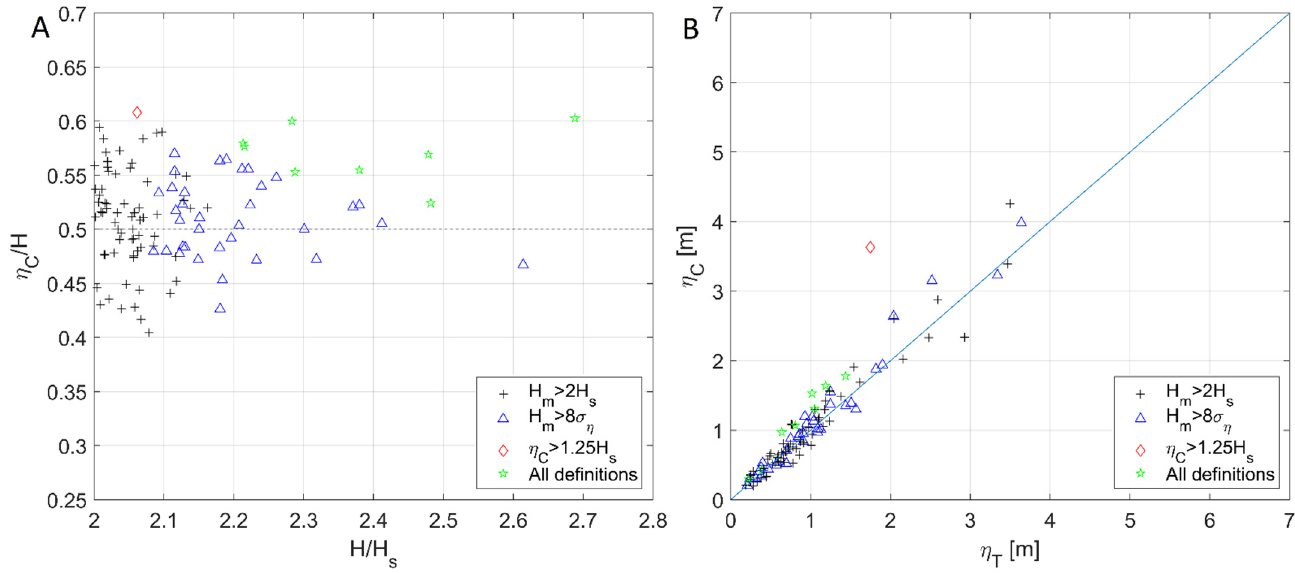
Figure 9. ( A ) Rogue waves (H/Hs above of 2) crest vs. trough heights distribution as a function of H/Hs. ( B ) Rogue waves crest vs trough heights distribution. Thresholds are denoted by: standard definition H ≥ 2Hs is denoted by +; crest height η c ≥ 1.25Hs denoted by ◊ ; STD of the instantaneous water elevation fluctuation H ≥ 8 σ η denoted by ∆ ; corresponds to all three threshold definitions denoted by ☆ .